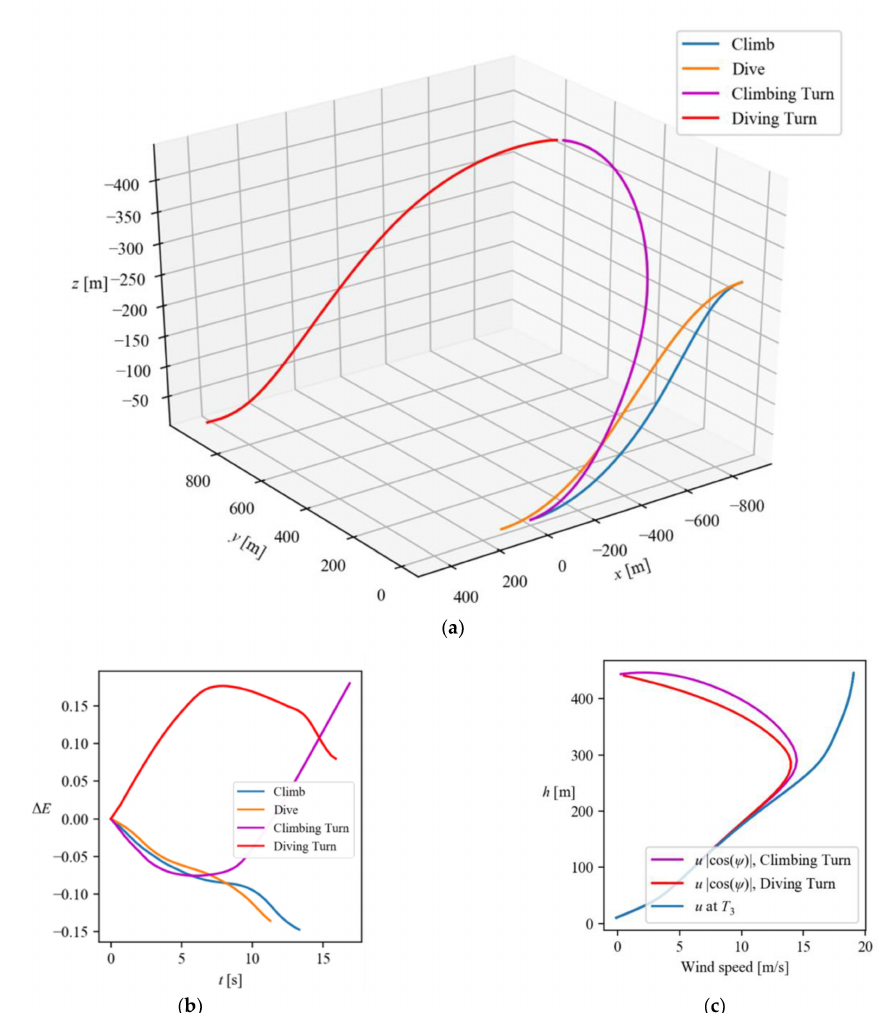
Figure 8. Results of simulations of climb, dive and turning segments of dynamic soaring, subject to simulated unidirectional wind at time T 3 . ( a ) flight trajectories; ( b ) time change of total energy; ( c ) wind